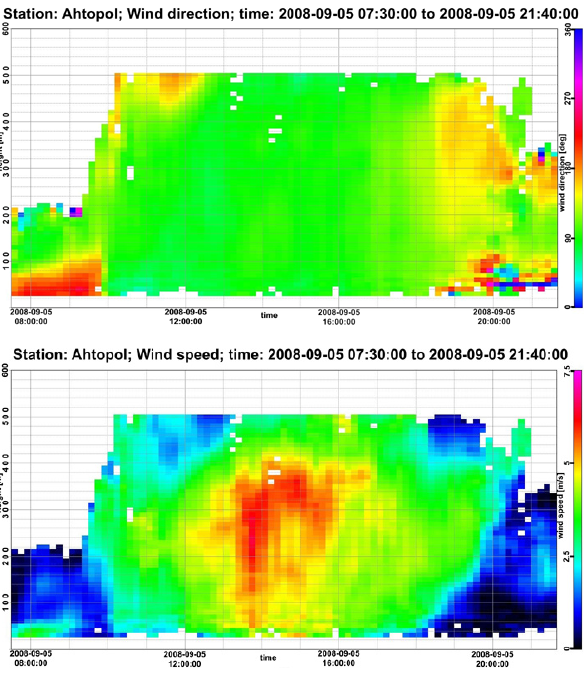
Figure 7. Notation is as in Fig. 6, but for 5 September 2008.